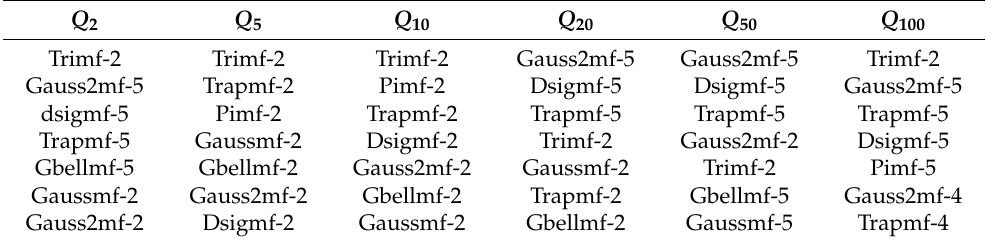
Table 3. Seven best-membership functions based on RMSE.